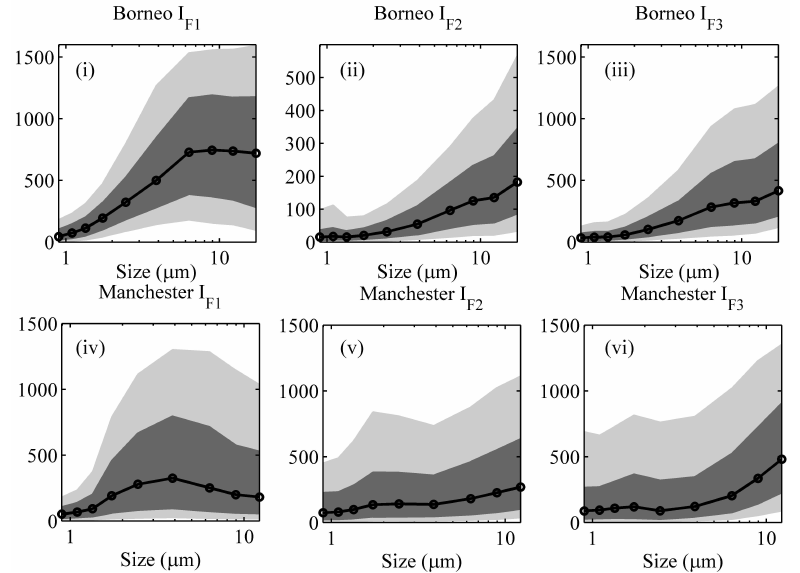
Fig. 8. Fluorescence intensity (arbitrary scale) versus D P in each WIBS3 fluorescence channel in Borneo (upper panel) and Manchester (lower panel). Solid line: median, dark shading: inter-quartile range, light shading: 10% and